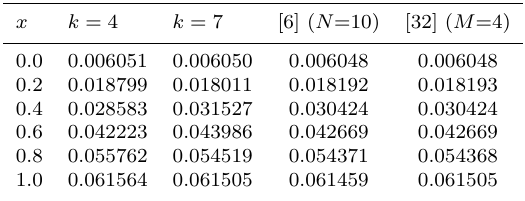
Table 7. Numerical results of Example 7.